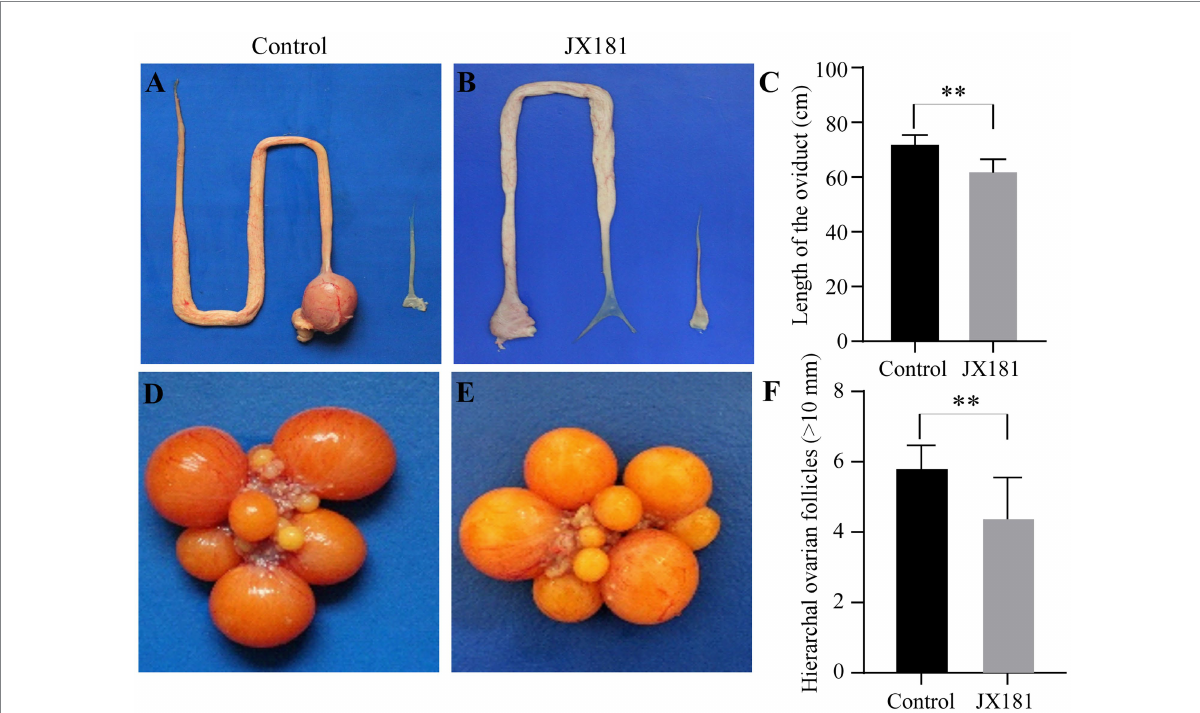
FIGURE 7 The lengths of the oviducts and the number of hierarchal ovarian follicles were impaired upon challenge with JX181 at 170 dpi. (A,B) The lengths of the oviducts were measured after the euthanasia of the chickens. (C) Statistical representation of the mean lengths of the oviducts. (D,E) The hierarchal ovarian follicles in mock and JX181 infected groups. (F) Statistical representation of the number of hierarchal ovarian follicles with diameters larger than 10